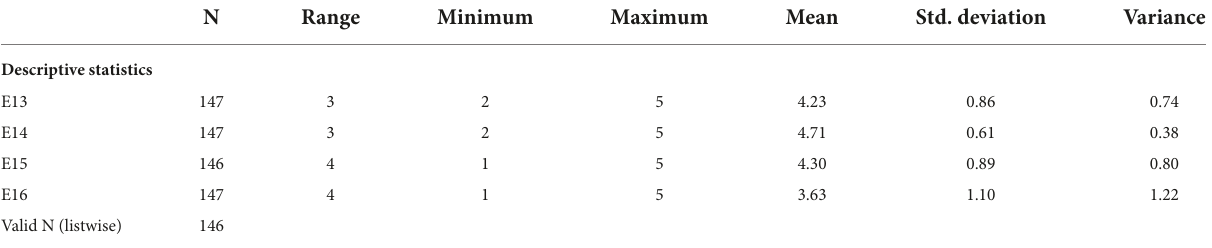
TABLE 5 Student effectiveness: descriptive statistics. N